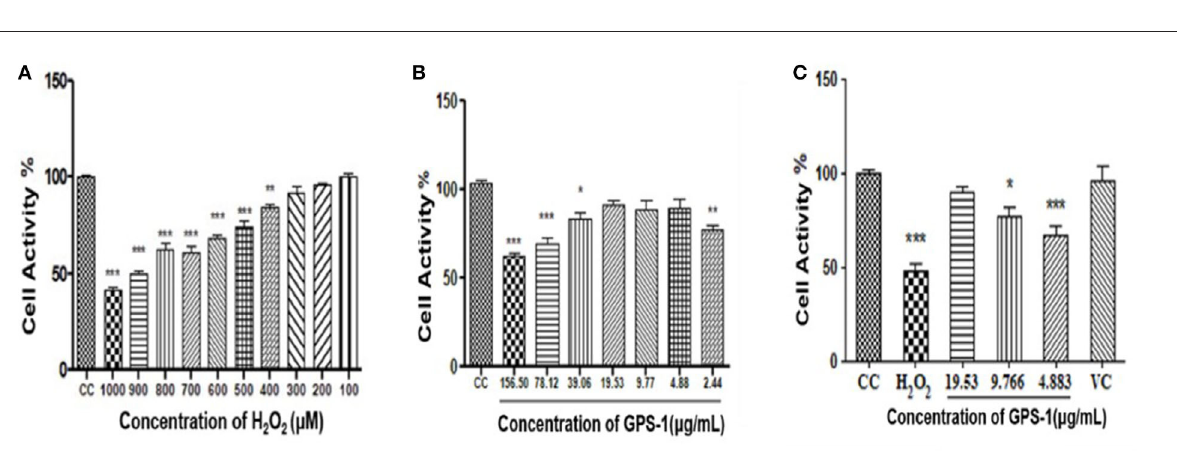
FIGURE6 Effect of H 2 O 2 on the survival rate of RAW 264.7 cells (A) Effect of GPS-1 on RAW 264.7 proliferation (B) Protective effect of GPS-1 against oxidative damage to RAW 264.7 cells induced by H 2 O 2 (C) Protective effect of GPS-1 on RAW 264.7 cells exposed to H 2 O 2 . * stands for P < 0.05; ** stands for P < 0.01; *** stands for P < 0.001.